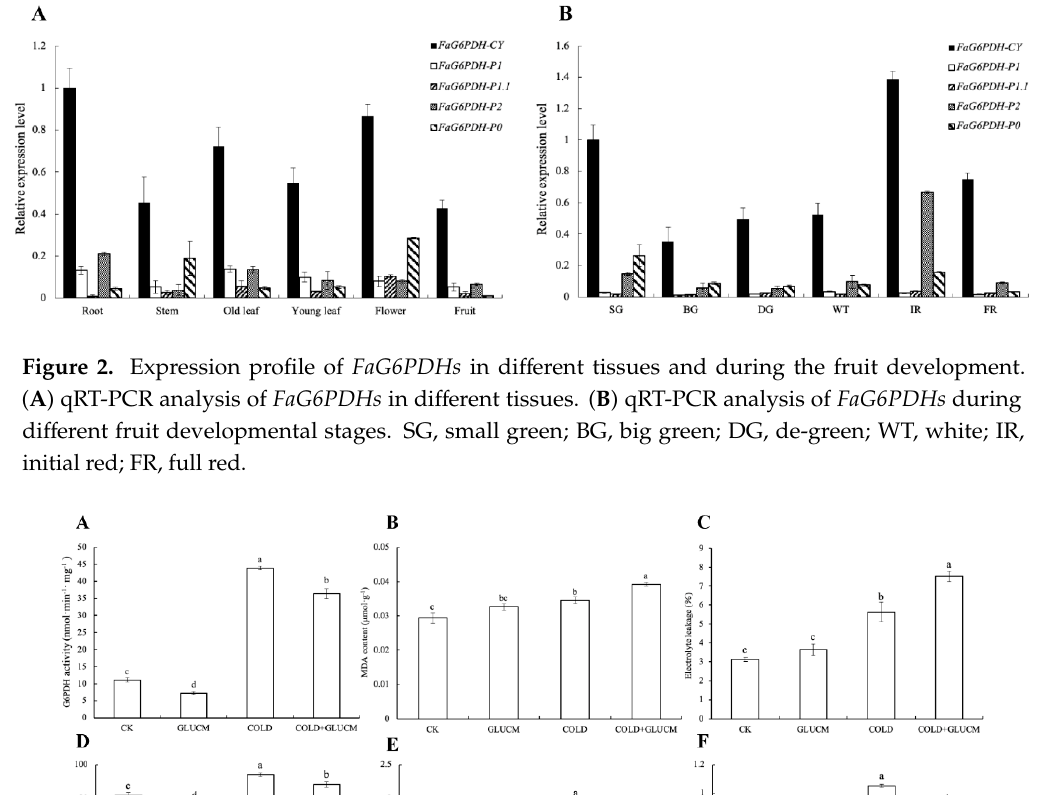
Figure 2. Expression profile of FaG6PDHs in different tissues and during the fruit development. ( A ) qRT-PCR analysis of FaG6PDHs in different tissues. ( B ) qRT-PCR analysis of FaG6PDHs during different fruit developmental stages. SG, small green; BG, big green; DG, de-green; WT, white; IR, initial red; FR, full red.